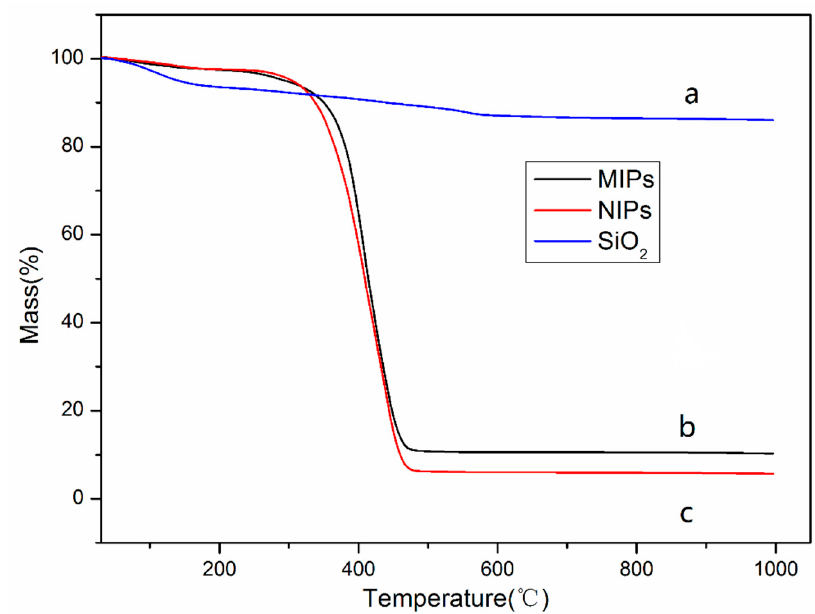
Figure 6. The thermogravimetric analysis (TGA) curves of SiO 2 ( a ), MIPs ( b ), NIPs ( c ).